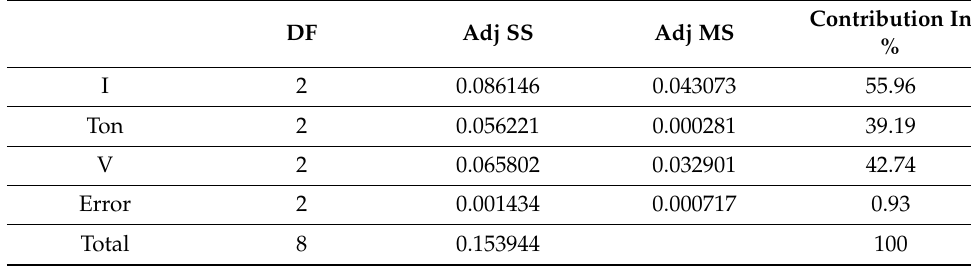
Table 5. Analysis of variance for sample